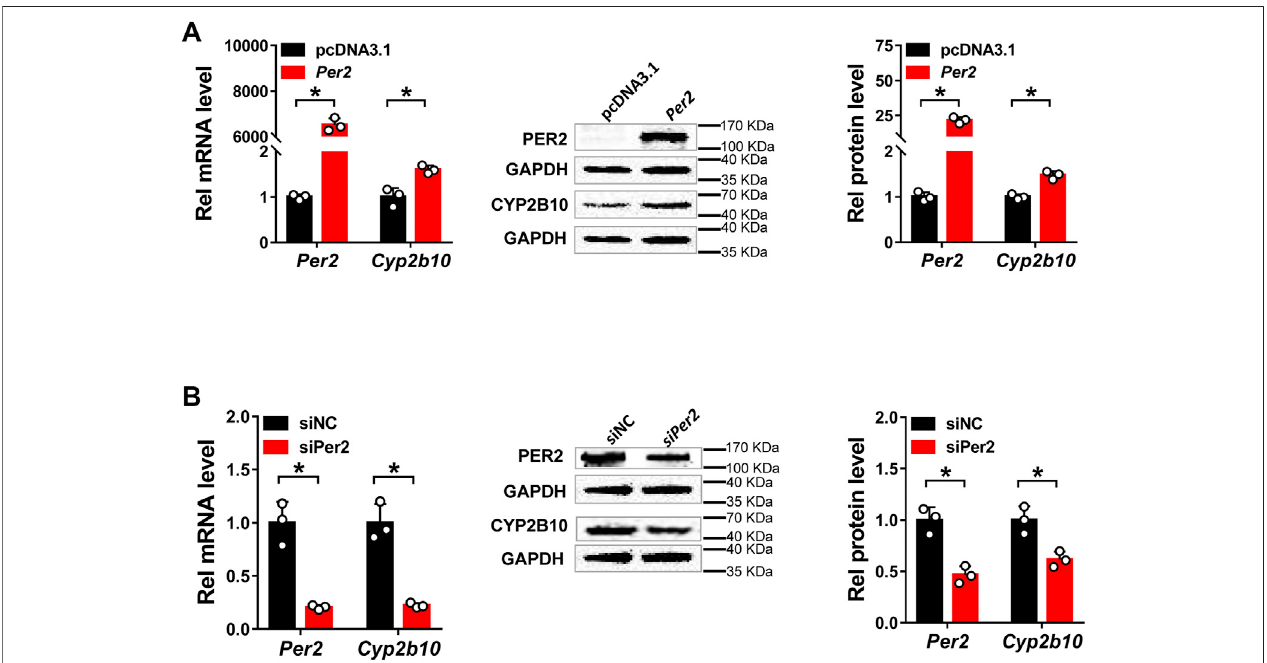
FIGURE7| Per2regulatesCyp2b10 expressioninAML-12cells. (A) Effectsof Per2 overexpressionontheexpression ofCYP2B10mRNAandprotein. (B) Effects of Per2 knockdownontheexpressionofCYP2B10mRNAandprotein.Westernblotstrips(atargetproteinandaloadingcontrol)werecutfromonegel.Dataaremean ± SD from three independent experiments. *p < 0.05 (t test). Rel,